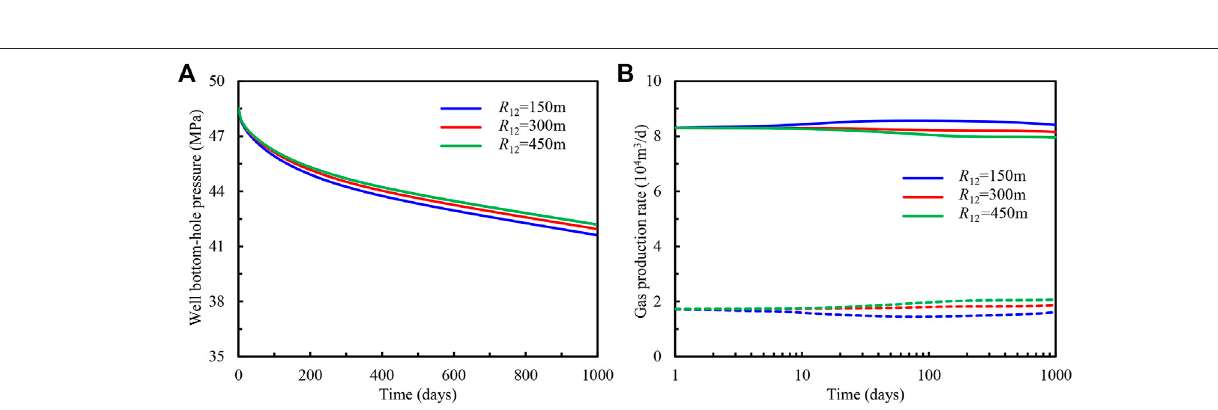
Frontiers in Energy Research |